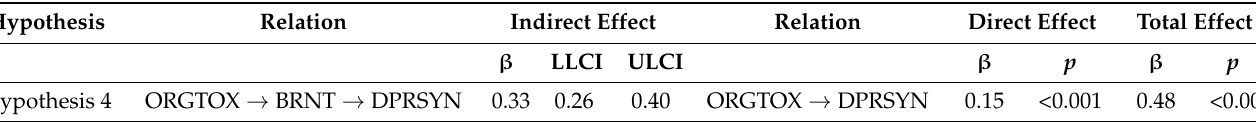
Table 6. Results of mediation